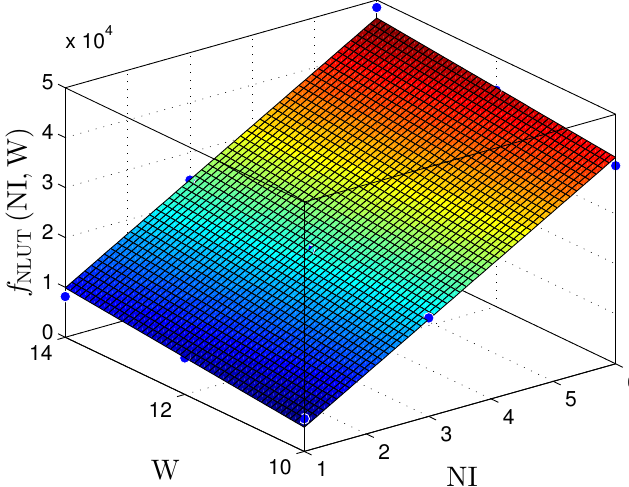
Figure 21. Plane, f NLUT ( NI , W ) , found to estimate the number of LUTs, NLUT, as a function of the number of implementations, NI, and the number of bits in fractional part W for MLP-based prediction techniques.